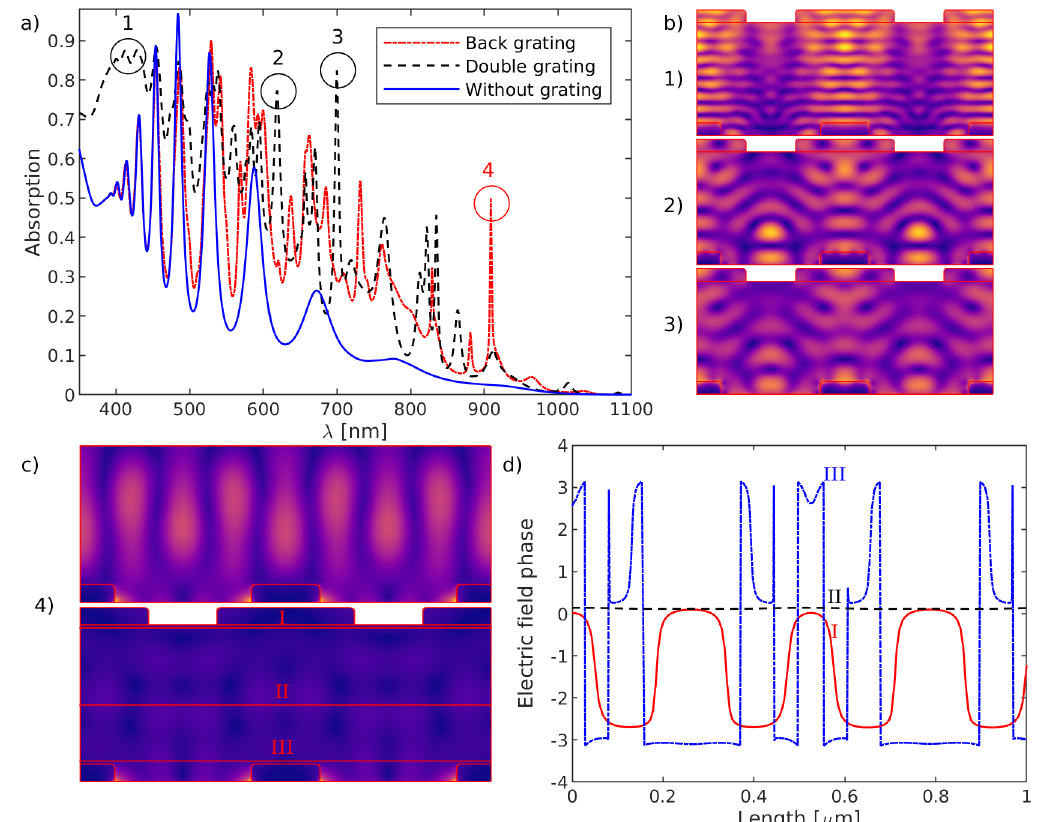
Figure 3. ( a ) simulated spectral response of the active layer’s optical absorption in structures without any grating (solid blue line), with an optimized periodic back grating (red dash-dotted line) and with a periodic double grating (black dashed line); ( b ) simulated electric field distributions at three first labelled operating wavelengths in the graph ( a ); ( c ) simulated electric field distributions at the fourth labelled operating wavelength in the graph ( a ), for structures with a periodic back grating and a periodic double grating; ( d ) phase of the electric field at the fourth labelled operating wavelength in the graph ( a ), for the structure with a periodic double grating displayed at the front grating (I), in the middle of the active layer (II) and at the back grating